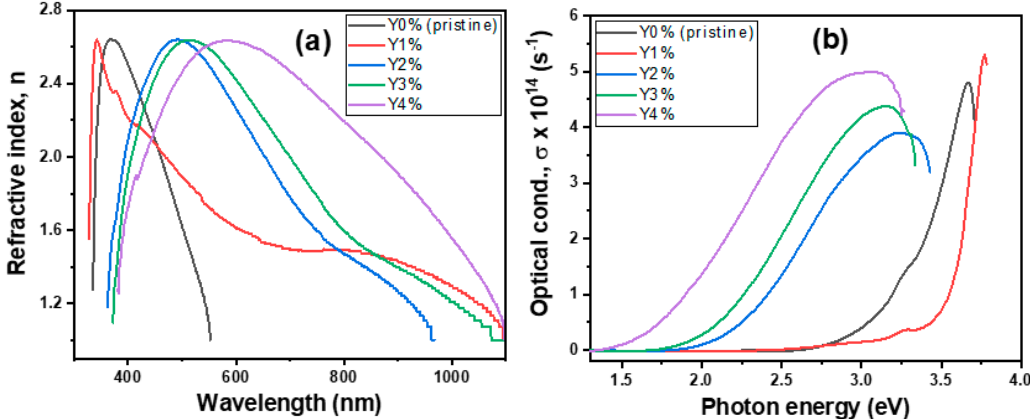
Figure 4. ( a ) Refractive index and ( b ) optical conductivity plots of pristine and composite films.